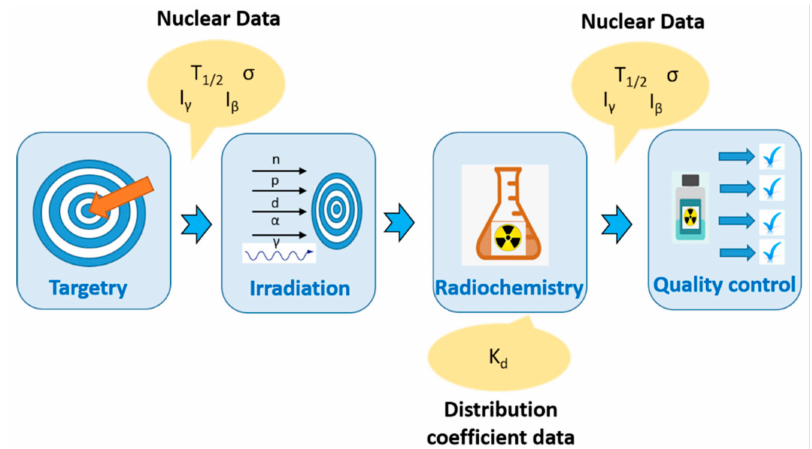
Figure 1. Stepwise radionuclide production of medical radionuclides (T 1 / 2 : half-life, σ : cross-section, I γ and I β branching